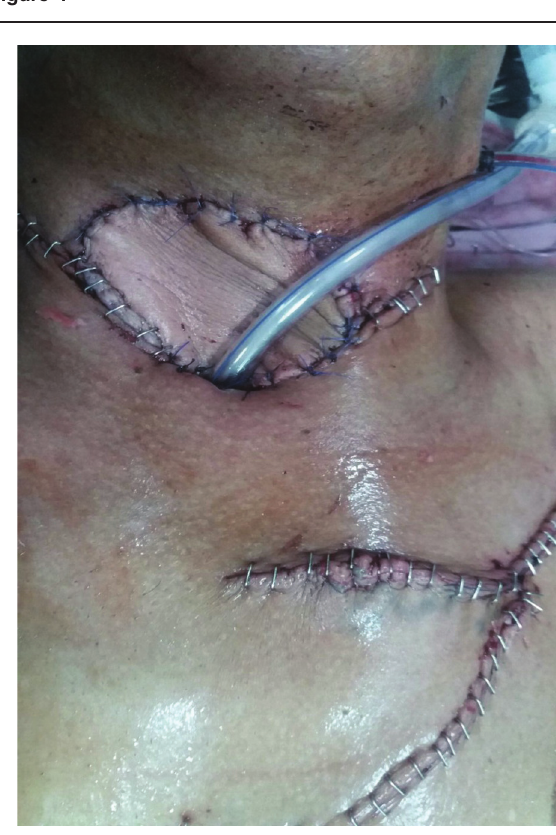
Immediate postoperative picture for the flap inset and donor site closure.